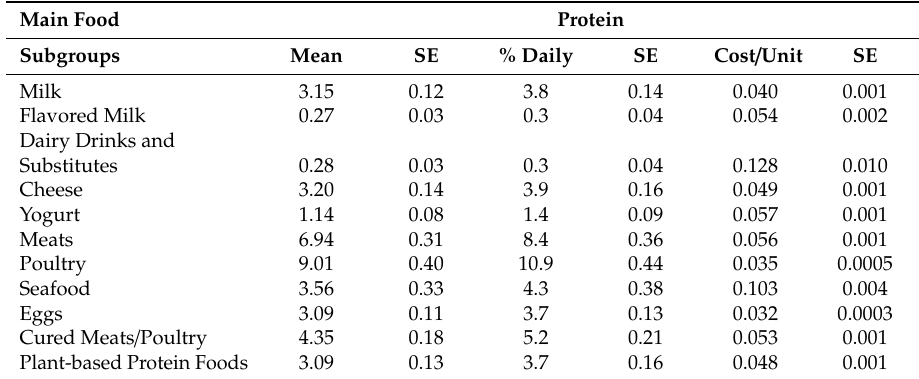
Table 8. Percent daily protein (g) and cost ($) of protein from eggs in adults compared to USDA protein food subgroups.